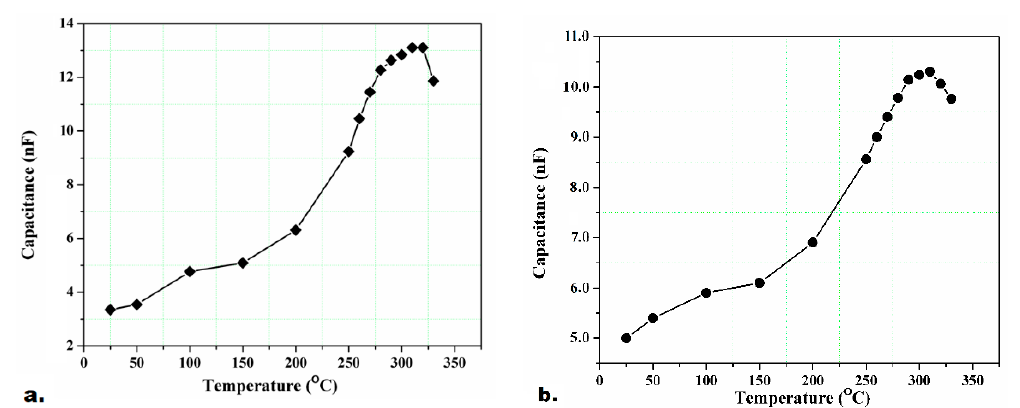
Figure 9. The C-T variations for the PZT/PZT films at 25–330 °C, ( a ) L 3 -A and ( b ) L 3 -B.